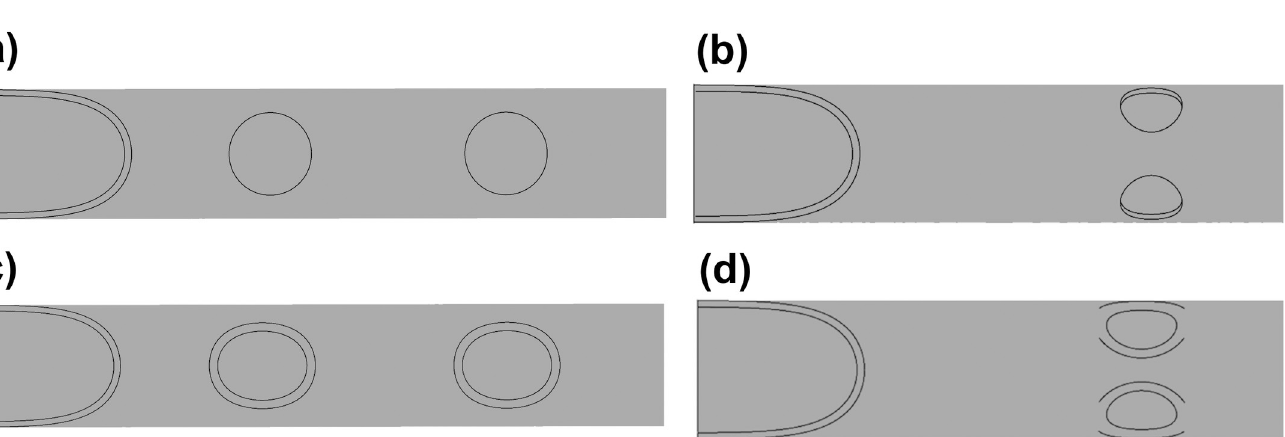
= 0.00345 Pa . s , n = 0.25, μ 1